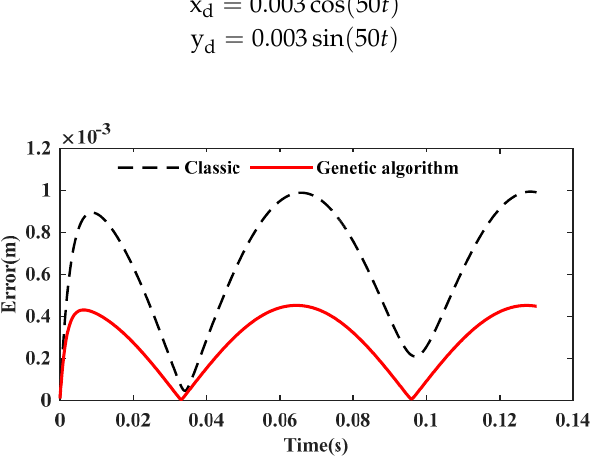
Figure 7. System control block diagram.